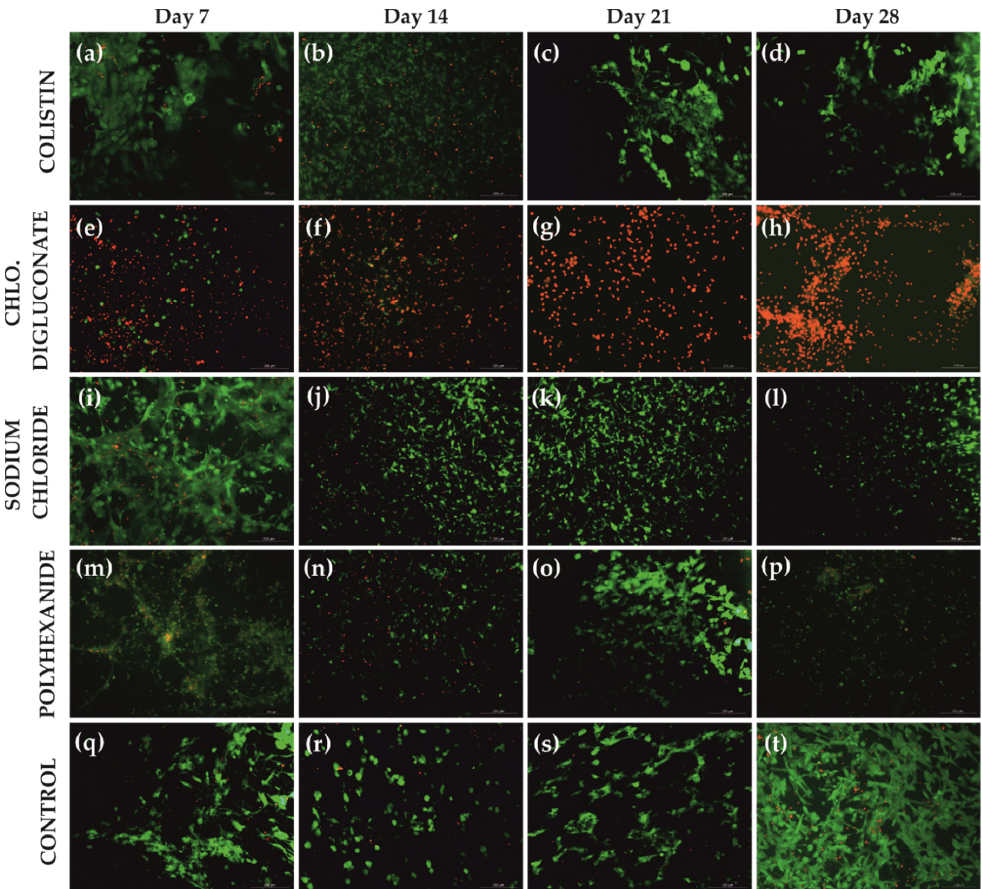
Table 1. Cell viability percentage media for each treatment and control at days 7, 14, 21, and 28; n = 3. Figure 4. LIVE/DEAD® images of BASS after each treatment and control at days 7, 14, 21, and 28. ( a – d ) BASS after colistin (1%) treatment at day 7, 14, 21, and 28 respectively. ( e – h ) BASS after chlorhexidine digluconate (1%) treatment at day 7, 14, 21, and 28, respectively. ( i – l ) BASS after sodium chloride (0.02%) treatment at day 7, 14, 21, and 28, respectively. ( m–p ) BASS after polyhexanide (0.01%) treatment at days 7, 14, 21 and 28 respectively. ( q – t ) Control at days 7, 14, 21, and 28 respectively. Live cells are represented in green and dead cells, in red. n = 3. Magnification 10 × .